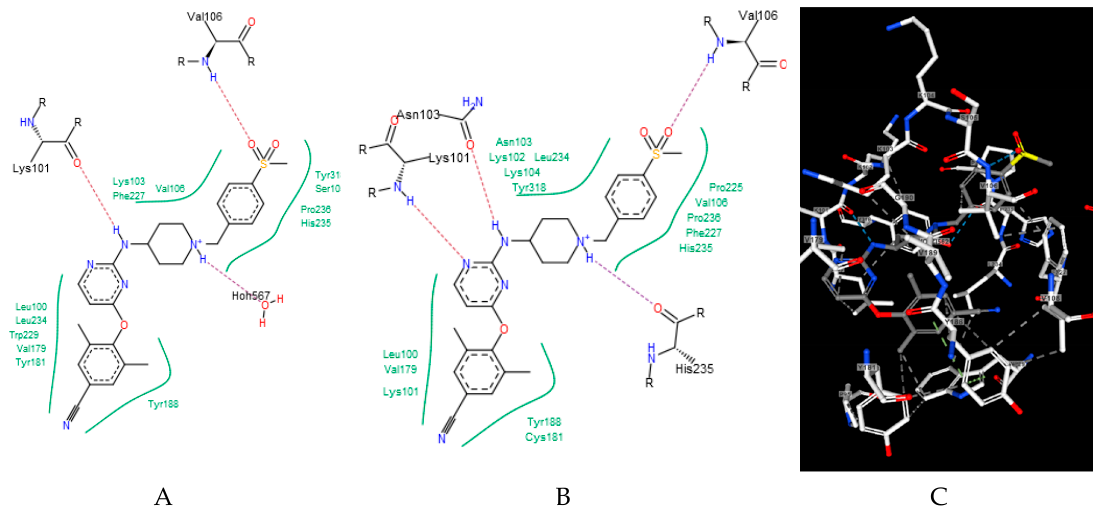
Figure 2. Binding of a DJZ ligand in allosteric pockets of ( A ) a wt native enzyme (3m8q) and ( B ) a K103N / Y181C mutant (Protein Data Bank [PDB] 3bgr). ( C ) A 3D representation of B.